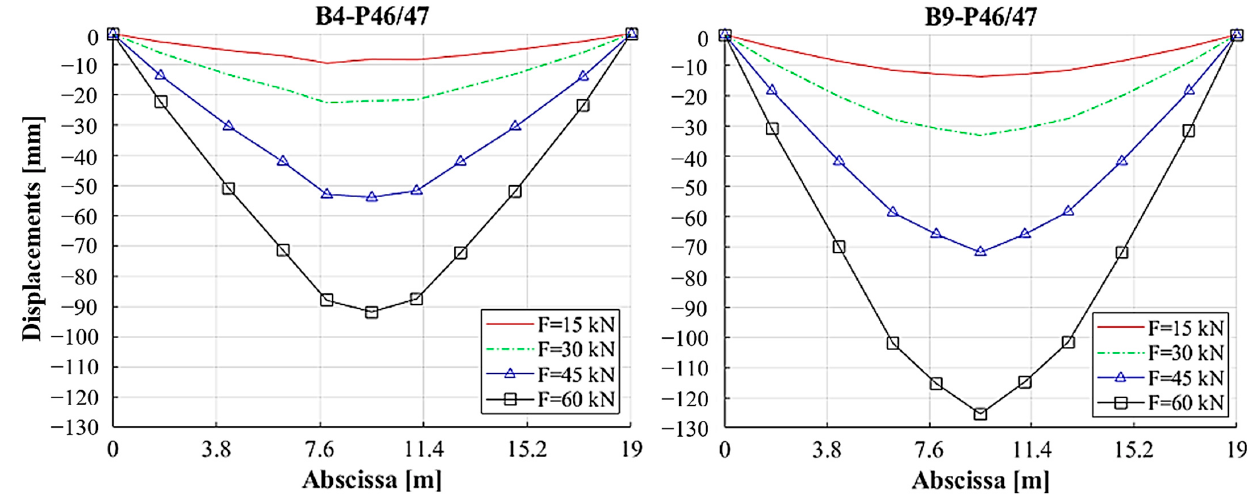
Figure 12. Longitudinal deformed shape of girders at 15, 30, 45 and 60 kN.